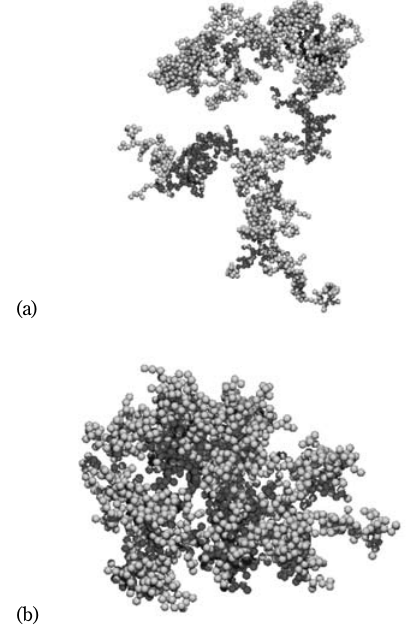
Fig. 4 Simulated aggregate structures for aggregates formed under (a) DLCA and (b) RLCA conditions. [Images kindly supplied by Dr. Graeme Bushell, Department of Chemical Engineering,